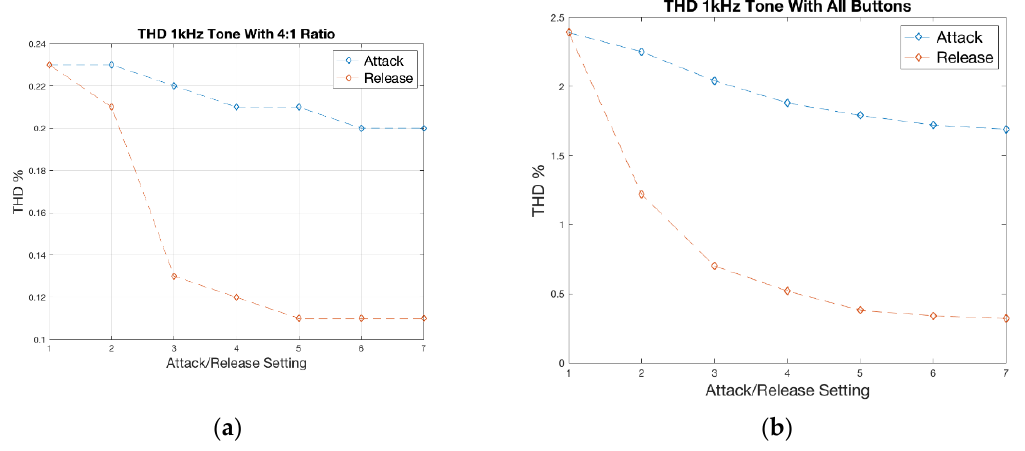
Figure 2. ( a ) Total Harmonic Distortion (THD) as a function of attack and release using a 4:1 compression ratio and a 1 kHz test tone; ( b ) THD as a function of attack and release using the “all-buttons” compression ratio and a 1 kHz test tone.